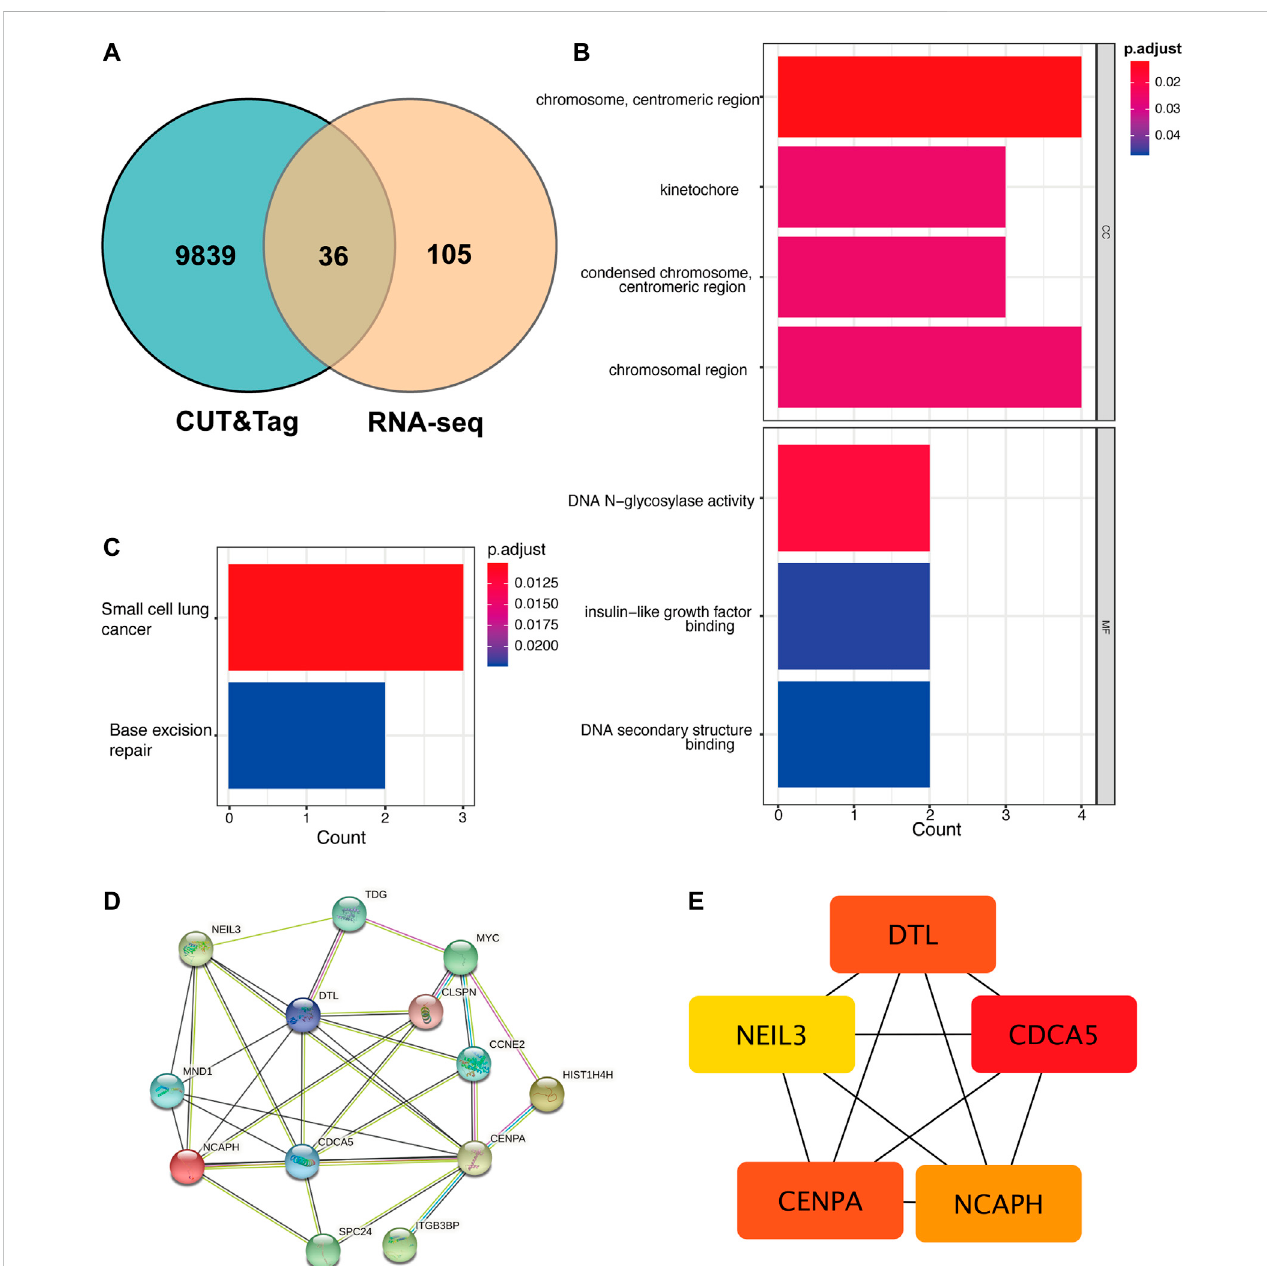
FIGURE 4 The cross-analysis of RNA-seq and CUT&Tag to identify the potential YAP target gene regulatory network mechanism. (A) . The Venn diagram of matching DEGs between RNA-seq and CUT&Tag seq. (B) . GO analysis of matching DEGs. (C) . KEGG analysis of matching DEGs. (D) . The PPI network of matching DEGs. (E) . Top fi ve hub genes of matching genes. DEG: differentially expressed genes, PPI: protein-protein